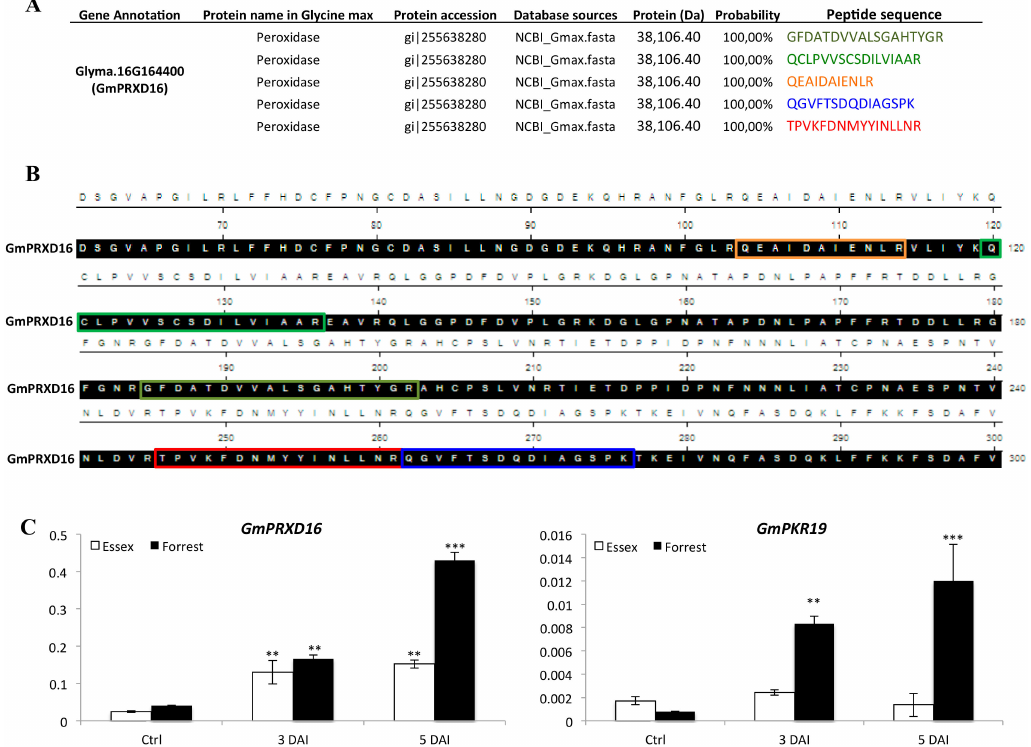
Figure 7. LC-MS protein identification of the eluted fraction obtained by immunoprecipitation using immobilized anti-SHMT08 antibodies and expression analysis. ( A ) Fragmented peptides identified by LC-MS in SCN infected root samples from Forrest. ( B ) Alignment of the GmPRXD16 protein sequence showing the five identified fragmented peptides by LC-MS. ( C ) Expression analysis of component of the ROS signaling pathway reveals that both genes are co-regulated in root cells undergoing nematode infection. Transcripts of genes encoding key components of the ROS signaling pathway including the peroxidase GmPRXD16 and the protein kinase GmPKR19 genes were induced and more abundant under SCN infection in the resistant line Forrest than in the susceptible line Essex. Asterisks indicate significant di ff erences between the tested lines as determined by ANOVA (*** p < 0.001, ** p < 0.01, * p <